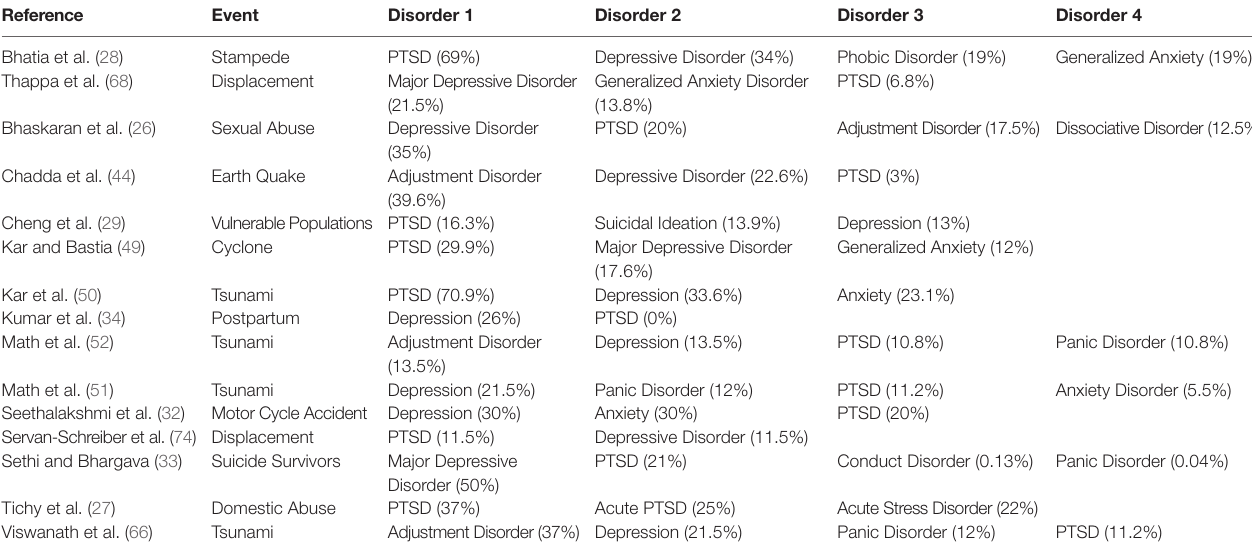
TABLE 2 | Overview of prevalence rates for top four trauma-related disorders by study.